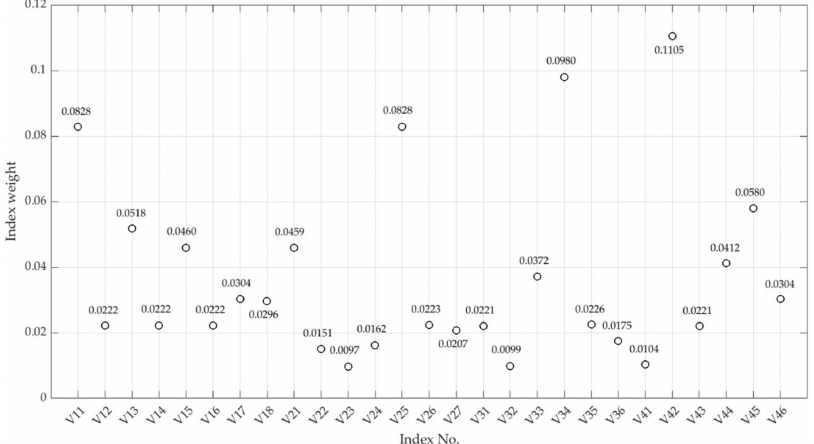
Figure 5. Optimal projection value of local emergency resilience.